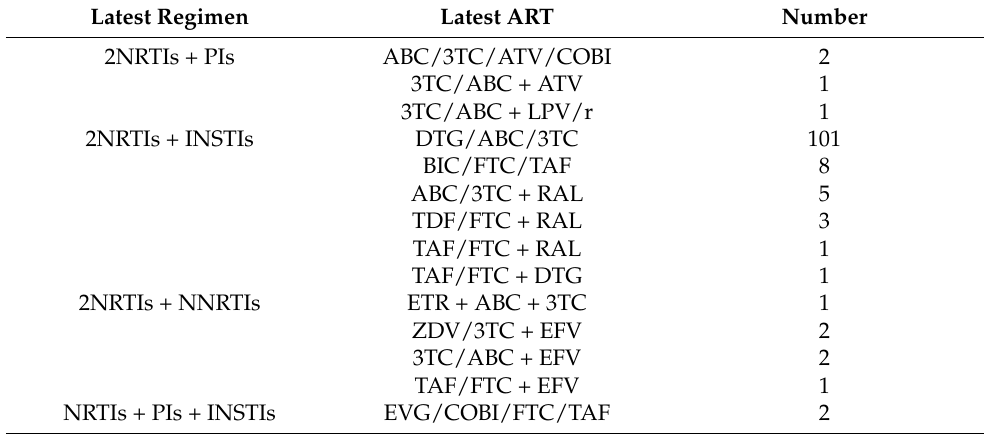
Table 2. Previously treated anti-retroviral